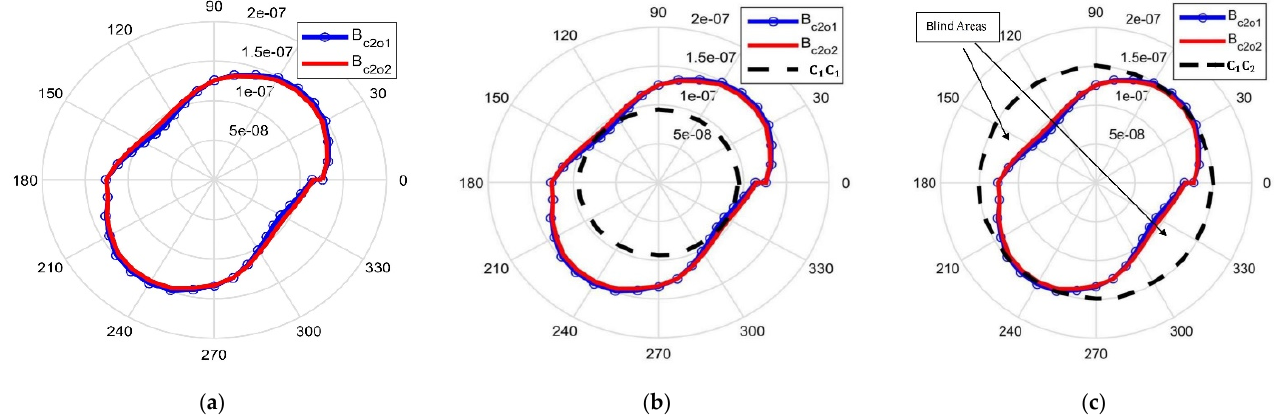
Figure 5. Max flux density of the magnetic fields and its directivity pattern calculated at xy plane, and keeping the z = 1 m, coil radius of transmitter Tx and receiver Rx = 0.104 m; turns of the coil are N = 28, current I = 1.62 × 10 − 7 , and frequency f = 125 KHZ. ( a ) Configuration 1. ( b ) Configuration 1 Case 1. ( c ) Configuration 1 Case 2.